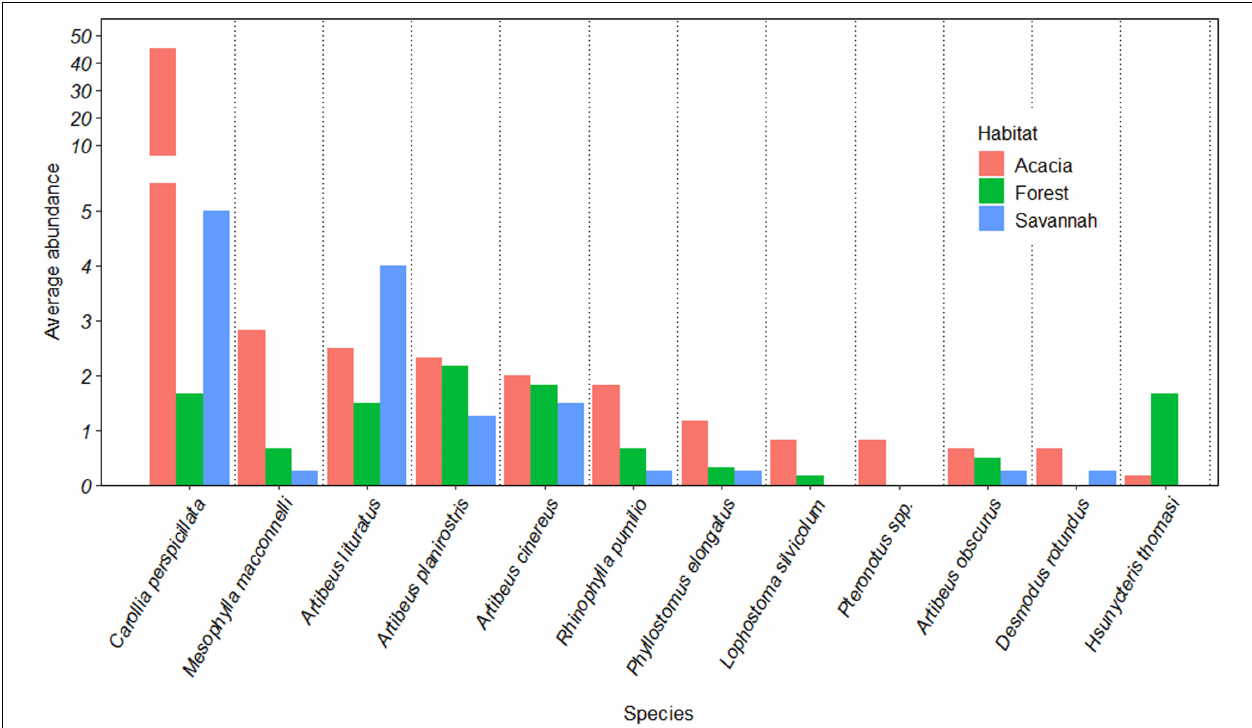
FIGURE 3 | Average abundance of the 12 most common bat species sampled in forest, savannah and acacia plantations in an Amazonian savannah in the northern Brazilian Amazon in 2017. The mean abundance values were estimated using the similarity percentages breakdown (SIMPER) procedure. For better visualisation of the data, the y -axis was expanded below the value of